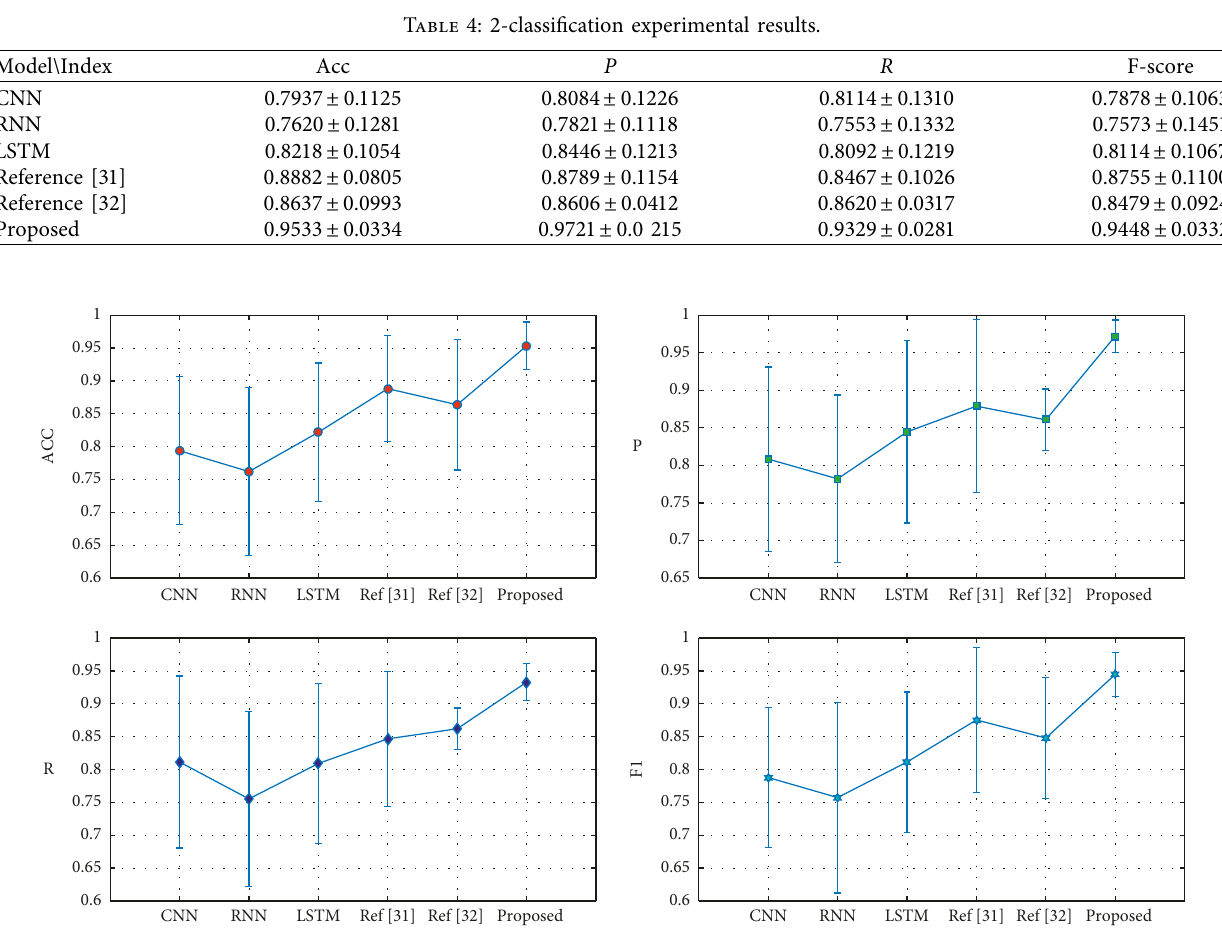
Figure 6: Experimental results of each model on different indexes in 2-classification task.